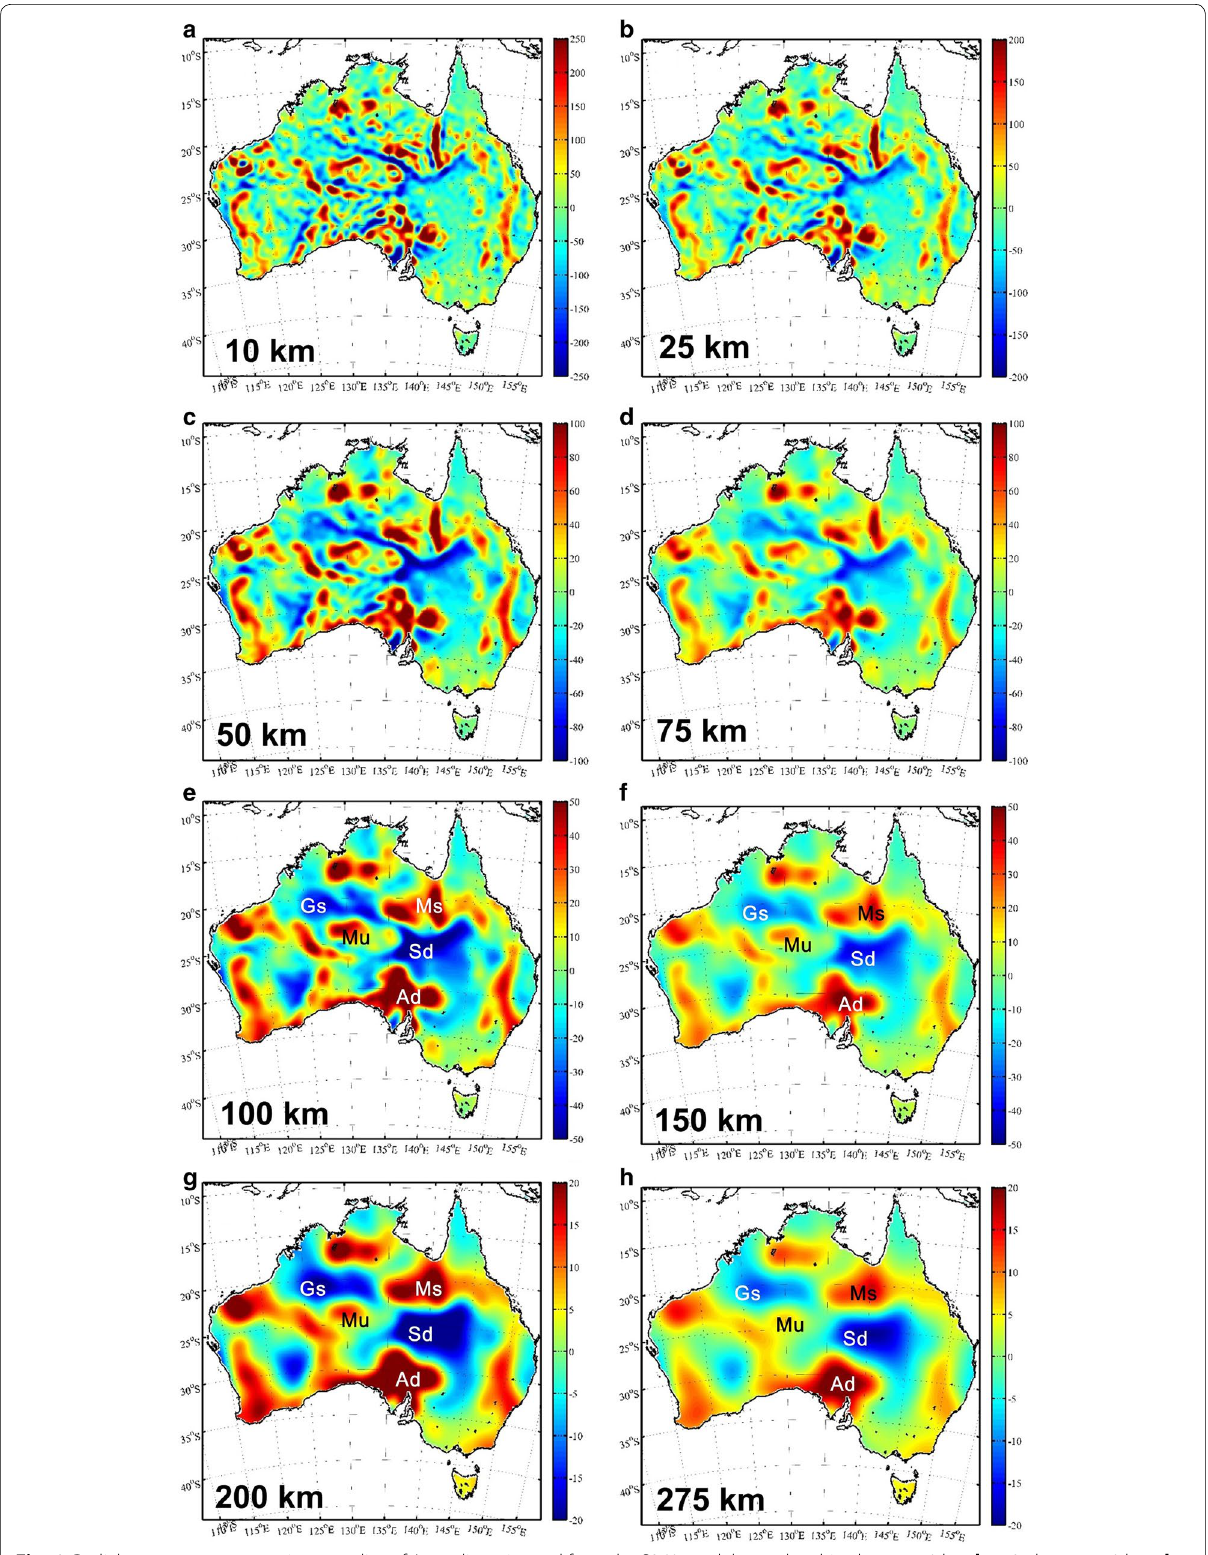
Fig. 6 Radial component magnetic anomalies of Australia estimated from the S360 model over the altitudes a at 10 km, b at 25 km, c at 50 km, d at 75 km, e at 100 km, f at 150 km, g at 200 km and h at 275 km, respectively. The feature annotations are listed in Fig